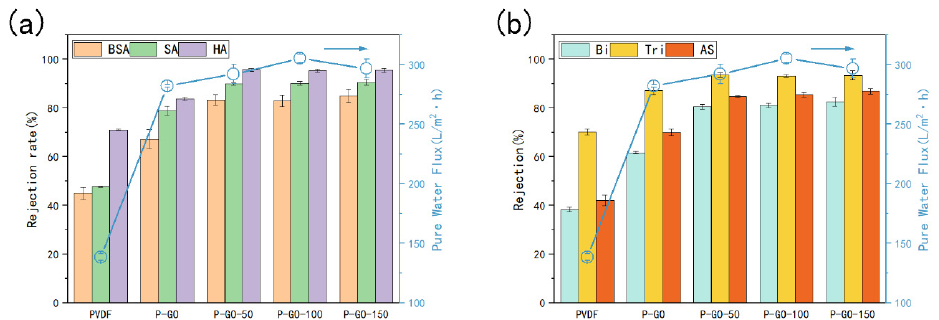
Figure 8. Pure water permeability and rejection rate for various foulants of pristine and functioned PVDF membranes: ( a ) rejection rate for BSA, SA, and HA; ( b ) rejection rate for Bi (binary foulants: BSA and SA), Tri (triple foulants: BSA, SA, and HA), and AS (Actual sewage: effluent of secondary sedimentation tank).